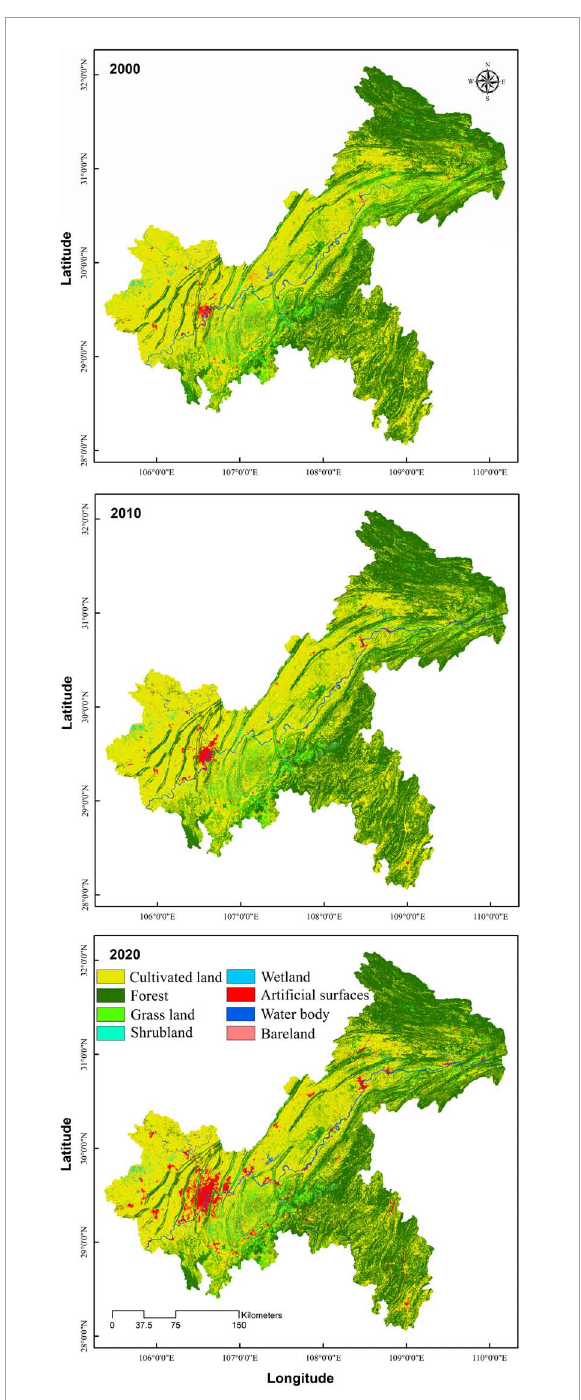
FIGURE2 Land use and land cover of Chongqing Municipality in 2000, 2010, and